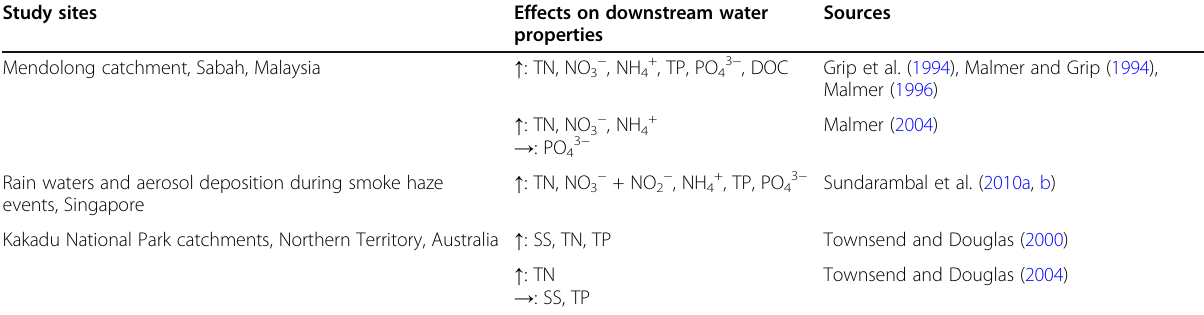
Table 5 A summary of the effects of wildfire or burning on the downstream riverine and estuarine water properties. The arrows before the water properties indicate that the subsequent water properties increased ( ↑ ), decreased ( ↓ ), or did not change ( → ). See the list of abbreviations for the water properties Study